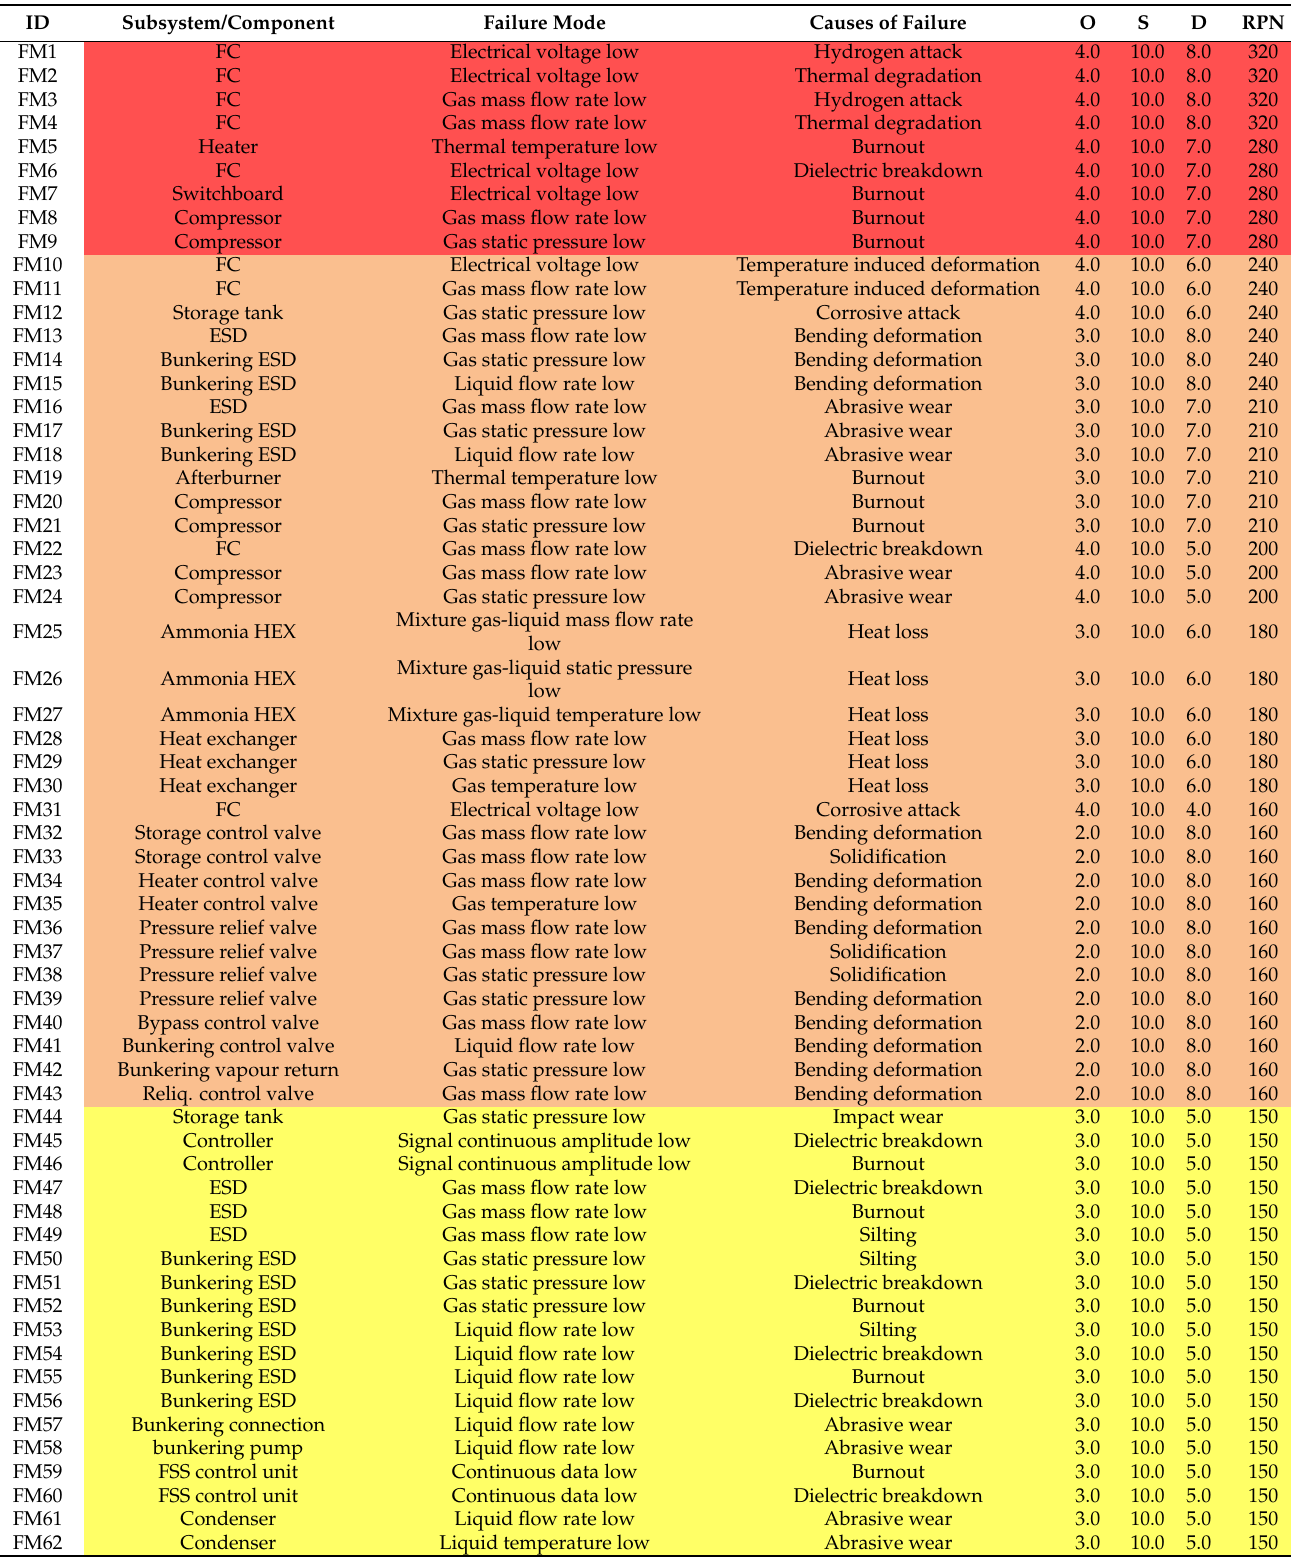
Table A1. FMECA analysis of the ammonia-powered fuel-cell system with 100 < RPN ≤ 150 considered moderate, 150 < RPN ≤ 250 considered moderately high, and 250 < RPN ≤ 350 considered